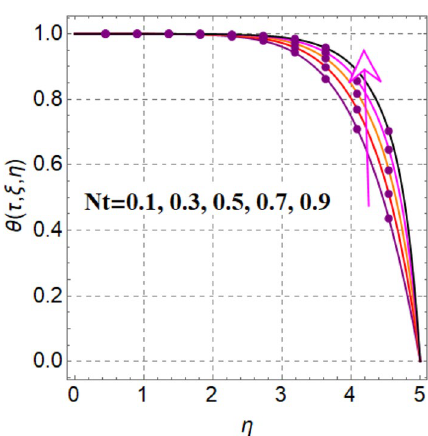
Figure 6. θ(τ , ξ , η) via Nt .